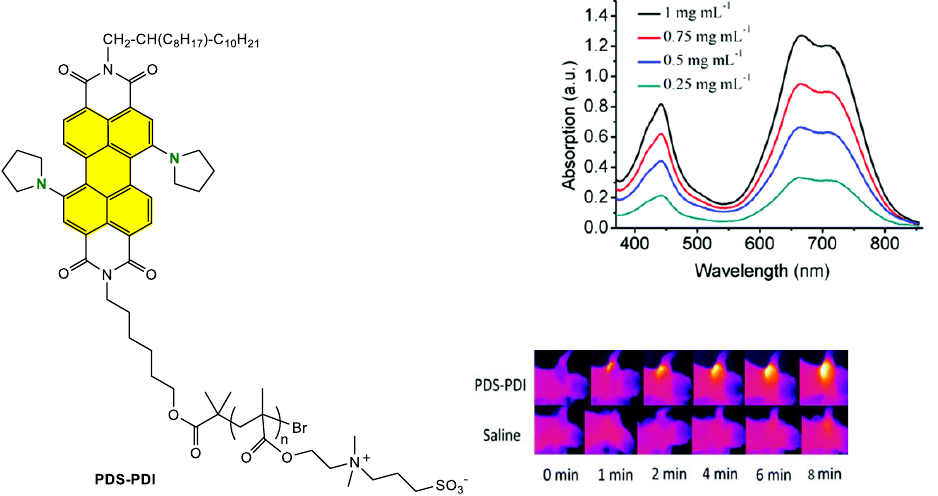
Figure 24. Structure of PDS-PDI; UV-Visible spectra of PDS-PDI in water at different concentrations; photothermal images of tumour tissue samples from MDA-MB-231 tumour-bearing mice intravenously injected with PDS-PDI (2 mg mL −1 , 100 μL) or saline upon 660 nm laser (0.5 W cm −2 ) irradiation. Reprinted with permission from Ref. [135]. Copyright 2018 Royal Society of Chemistry.